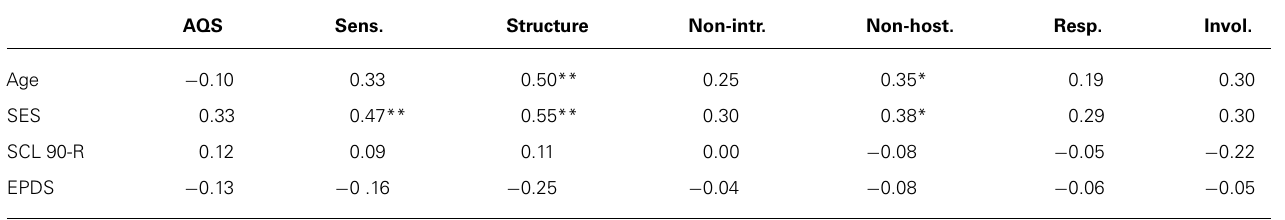
Table 3 | Bivariate correlations ofAQS and EmotionalAvailability Scales scores with family SES, maternal age, SCL 90-R (GSI), EPDS. AQS